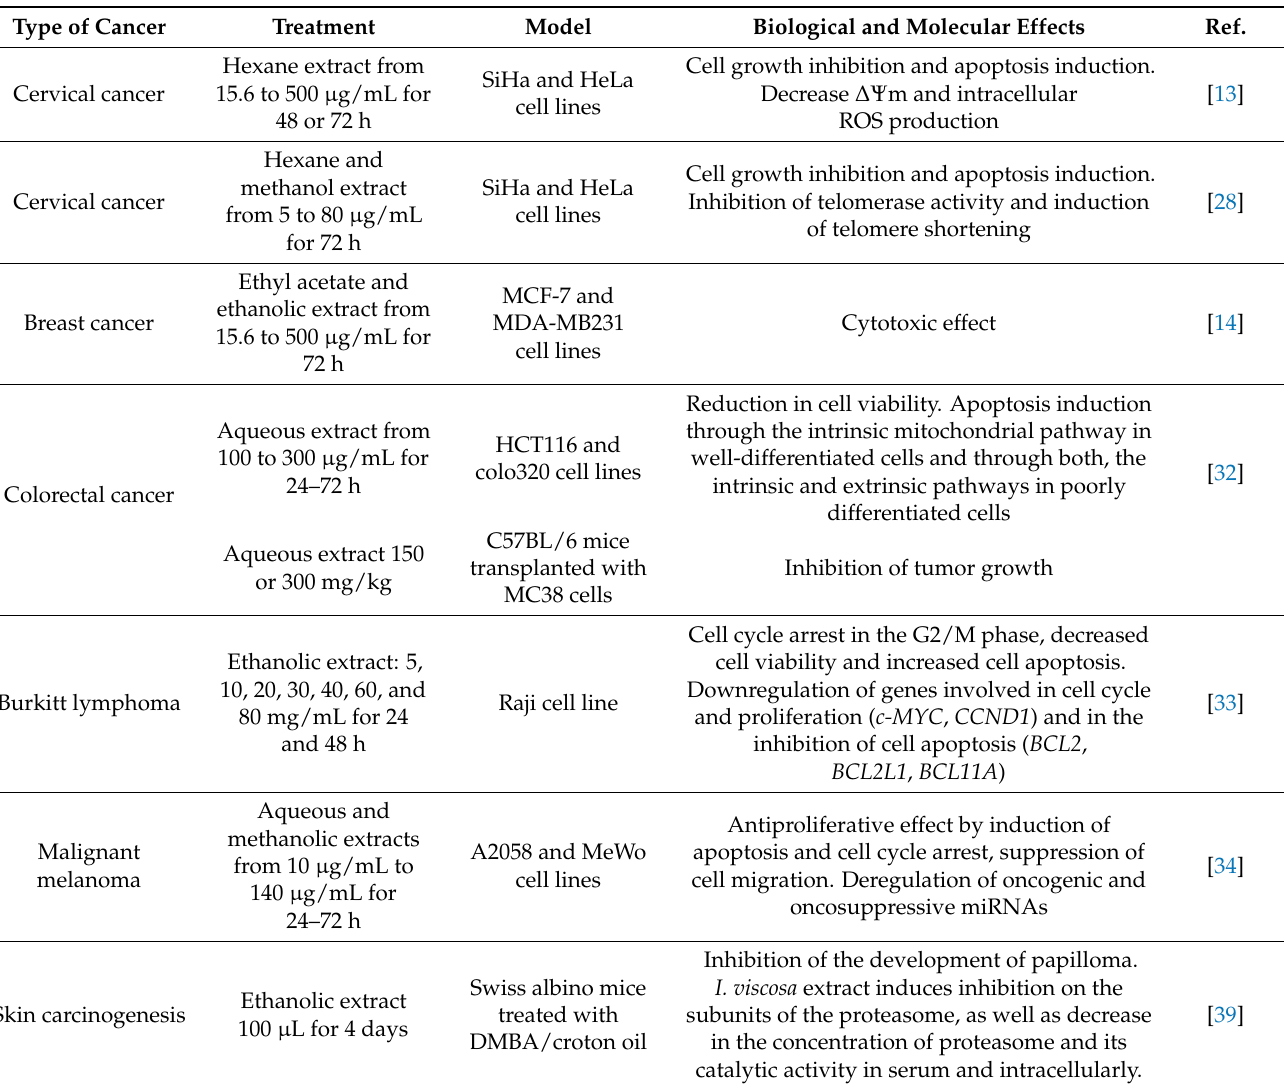
Table 1. Summary of biological and molecular effects induced by Inula viscosa treatment with in vitro and in vivo system